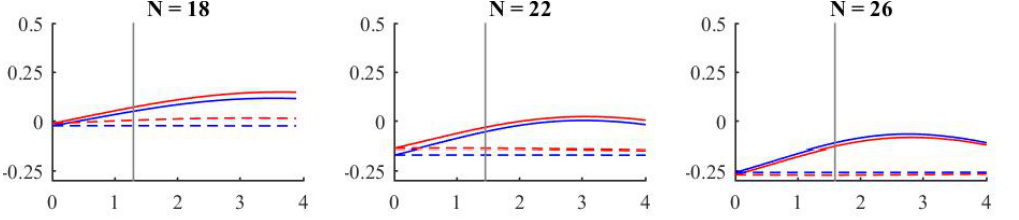
Figure 28 . Comparing the traversable wormhole correlator (4.24) in the thermal state (blue) and typical state (red). The dotted line is the signal without the probe, which is the response one obtains from just the state-dependent perturbation and should disappear in the large N limit, in this case a sum over (cid:12)ve pairs of operators was used in the perturbation to limit this e(cid:11)ect. The vertical line denotes the scrambling time and is the time around which the probe is